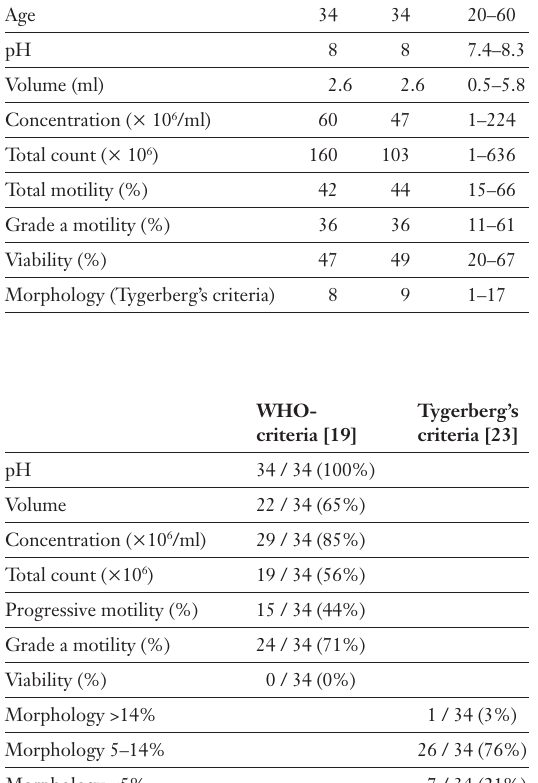
Sperm analysis of fertile Swiss men (n = 34).